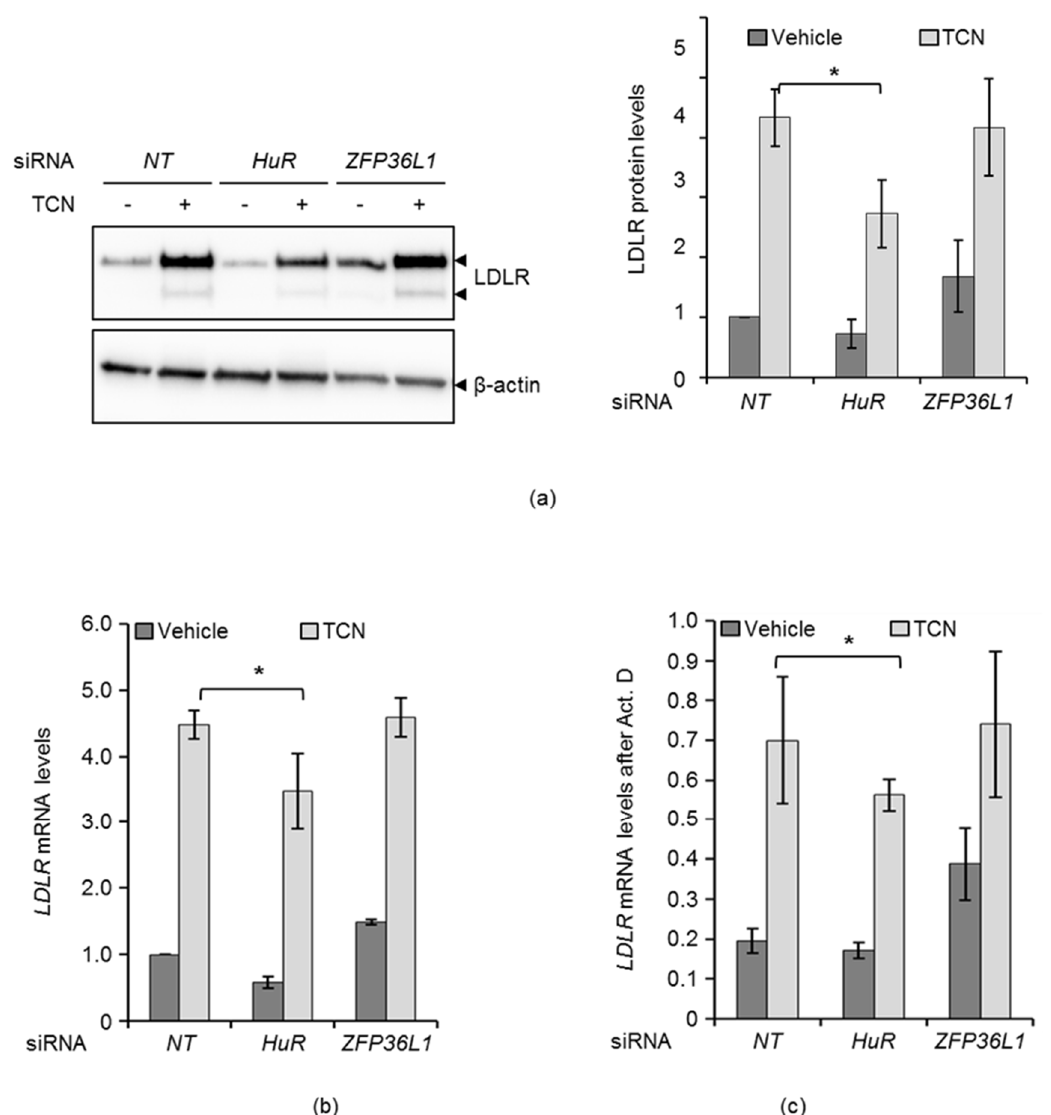
Figure 2. HuR and ZFP36L1 contribute to triciribine (TCN)-mediated stabilization of LDLR mRNA. ( a ) HepG2 cells were transfected with either a non-targeting (NT), 1HuR or ZFP36L siRNA. Twenty-four hours post transfection, cells were treated with or without TCN and harvested after four hours. Lysates were subjected to immunoblotting with the indicated antibodies. One representative blot is shown ( n = 4). The graph in the right panel depicts the intensity of LDLR after normalization to the β -actin protein ( n = 4). ( b ) A similar experiment, as described in ( a ), was performed and cells were subjected to total RNA extraction and qPCR of LDLR mRNA, normalized to GAPDH. Error bars show standard deviation of the mean. * p < 0.05, n = 3. ( c ) Twenty four hours post transfection, cells were added TCN, or not, for four hours before being exposed to Act D. Cells were harvested at time zero (without Act D) and after four hours with Act D, respectively, and subjected to total RNA-extraction and qPCR of LDLR mRNA, normalized to GAPDH mRNA. The graph shows the LDLR mRNA level remaining after four hours Act D treatment in vehicle and TCN-treated cells. Error bars show standard deviation of the mean. * p < 0.05.